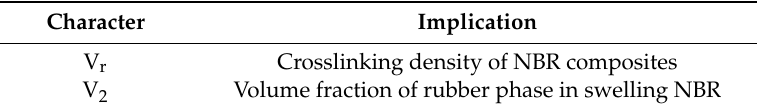
Table 2. Definitions of the terms in Equations (1) and